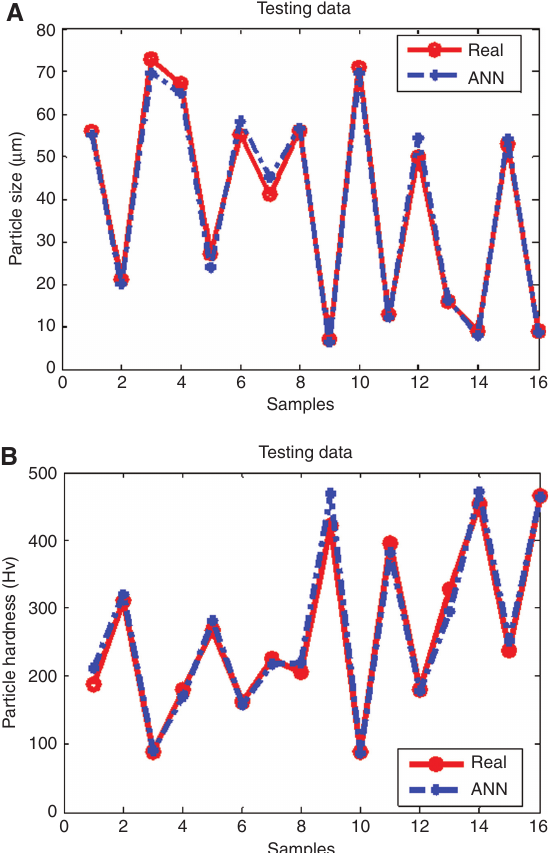
Figure 9 Comparison of the real and calculated values for testing data set: (A) particle size ( μ m) and (B) particle hardness (Hv).